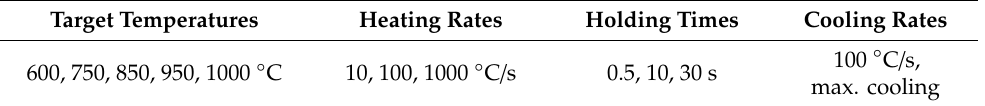
Table 2. Parameter settings realized in the dilatometer experiments .